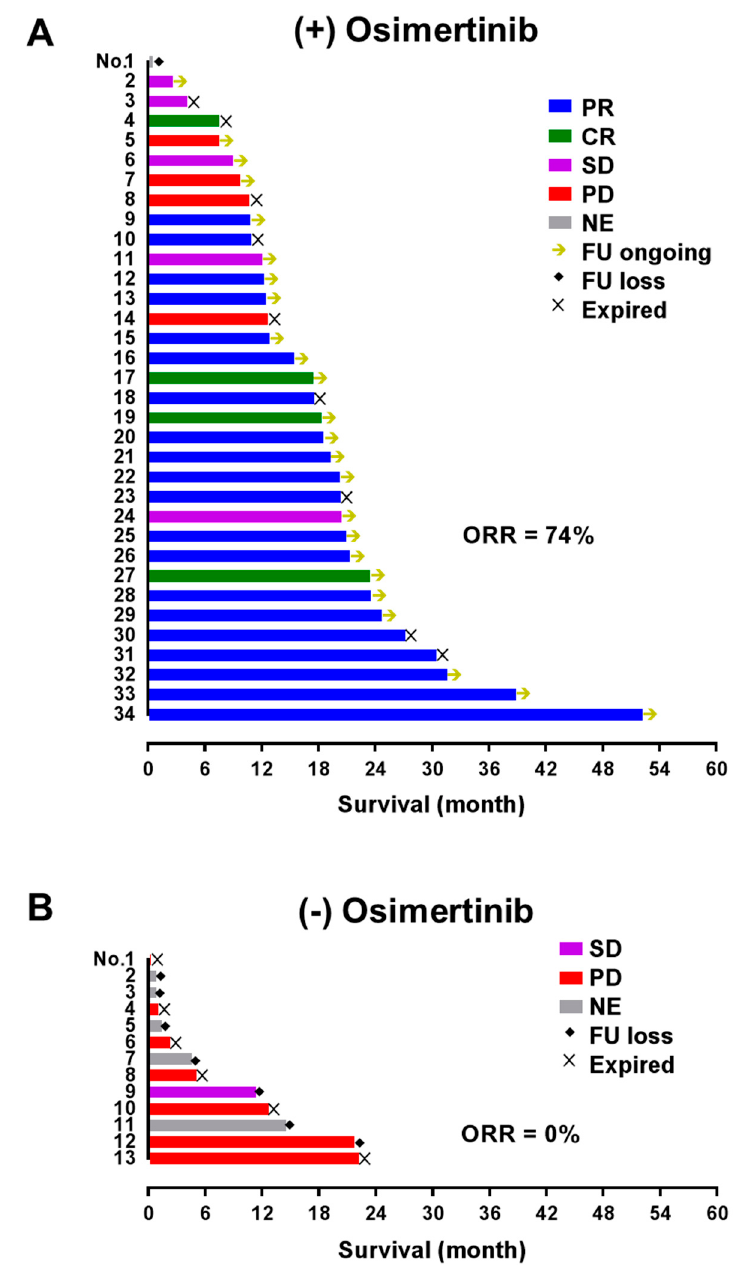
Figure 3. Survival and the best tumor response in patients with EGFR T790M mutation. ( A ) Patients who received osimertinib following development of drug resistance and T790M detection. All patients had previously received 3–10 lines of treatment, and osimertinib was used based on detection of T790M mutation using the PNA clamping test. ( B ) Patients with late-stage disease who were diagnosed with T790M mutation (by PNA clamping test: n = 10; by PANAMutyper and cobas v2: n = 3) but did not receive osimertinib. Arrows indicate ongoing follow-up; diamonds indicate loss to follow-up. PR, partial response; CR, complete response; SD, stable disease; PD, progressive disease; NE, not evaluated; FU loss, loss to follow-up; ORR, objective response rate.